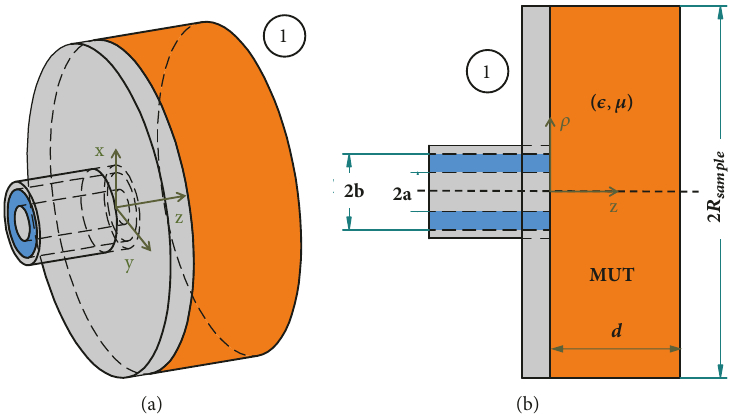
Figure 1: Schematic of the one-port open coaxial used for dielectric measurement, showing the material under test (MUT) with its dielectric properties: (a) 3D schematic view; (b) longitudinal cut (revolution symmetry with respect to z).